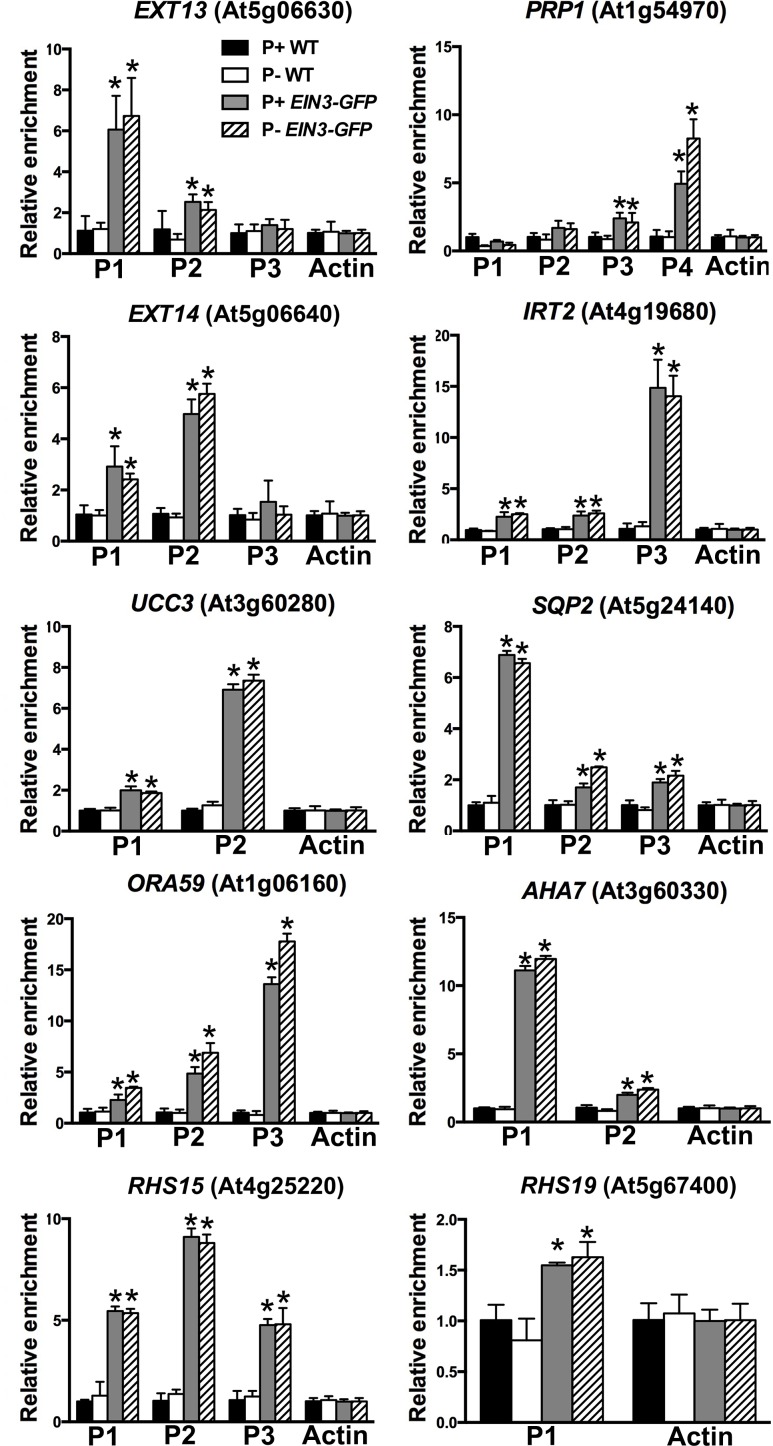
ChIP-qPCR assays of the binding of the EIN3 to the promoters of ten selected genes.Chromatins from the WT and 35S::EIN3-GFP transgenic plants were isolated and immuno-precipitated with GFP-Trap. The levels of enrichment of the precipitated DNA fragments were quantified by qPCR assays. An actin gene fragment was amplified as the internal control. Values are means ± SD of three replicates. Experiments were repeated two times with similar results. Asterisks indicate a significant difference from the WT (t-test, P < 0.05).